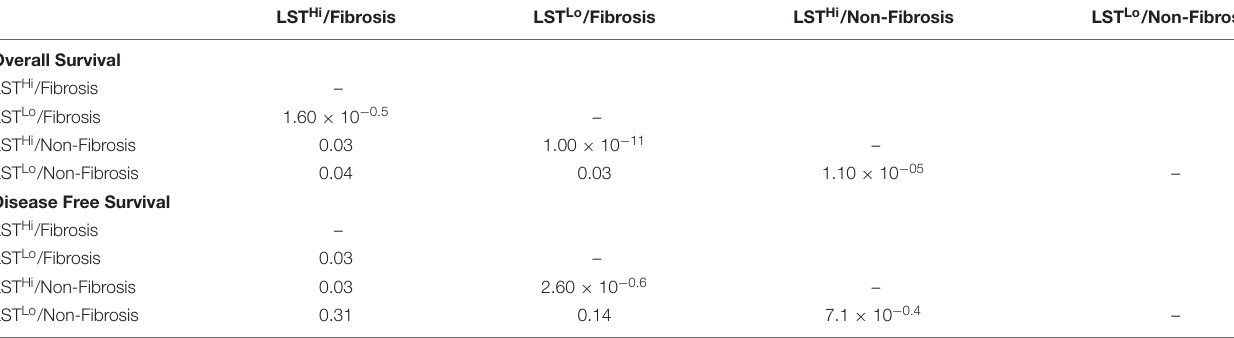
TABLE 5 | Pairwise comparison of transcriptomic and genomic signatures for overall and disease-free